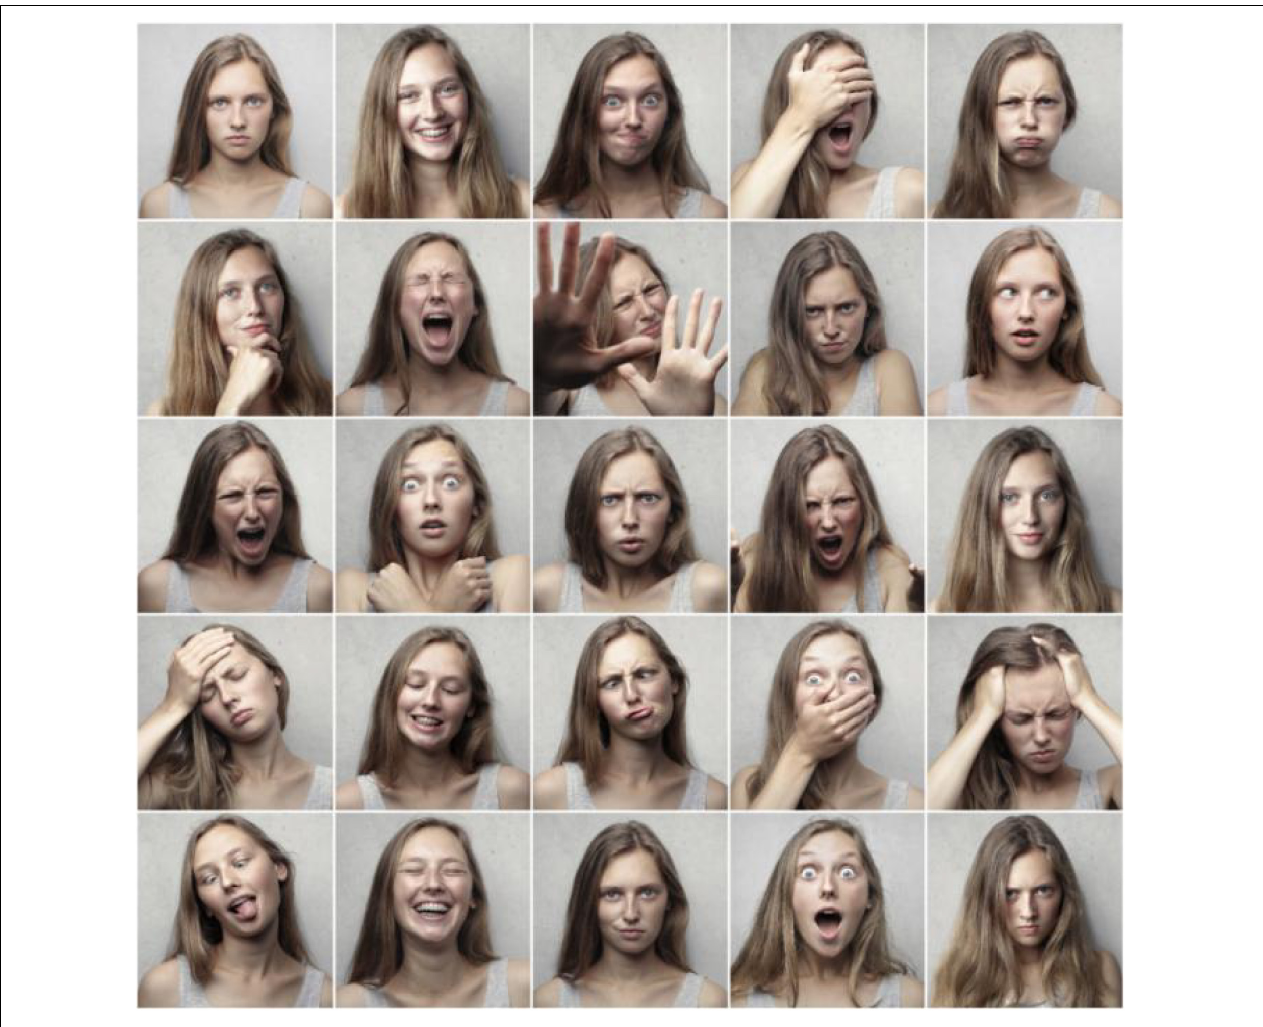
FIGURE 2 | Sample training sample set of different